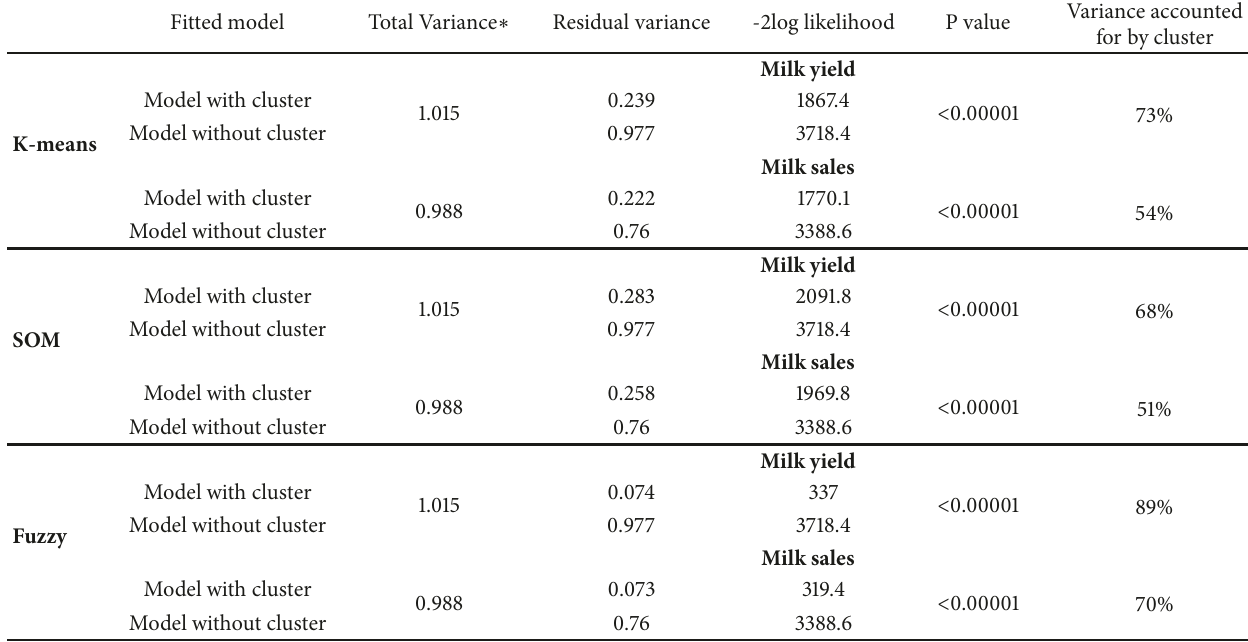
Table 10: Proportion of variance accounted for by cluster of production in Ethiopia.